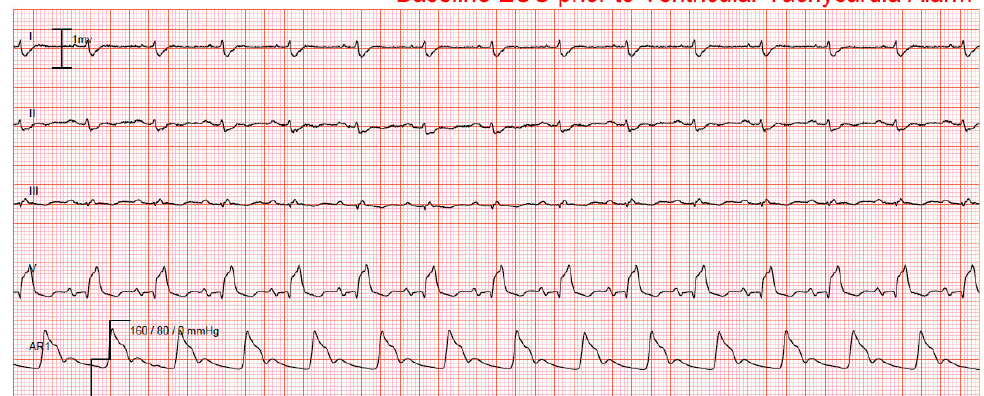
Figure 2. The figures above are rhythm strips showing leads I, II, III, and V (V1—at our hospital) and an arterial blood pressure waveform (AR1) in an intensive care unit patient. The top rhythm strip is an alarm for ventricular tachycardia (VT) during acute respiratory distress. Note the arterial blood pressure is unchanged at 146/89 mmHg and the Sp02 is 96% during the alarm. The bottom figure is a rhythm strip prior to the VT alarm showing normal sinus rhythm, first degree atrioventricular block with right bundle branch block (BBB). The arterial blood pressure is 138/59 and Sp02 is 99%. The QRS morphology in lead V1 in the top strip is identical to that of in the bottom tracings; hence, the top strip in not VT, but rather sinus tachycardia in a patient with right BBB during acute respiratory distress. This patient had a total of 79 false VT alarms (wide QRS heart rate > 100 beats/min) and 120 alarms for accelerated ventricular rhythm (wide QRS < 100 beats/min) during a seven-day ICU stay, illustrating the issue of false alarms due to BBB. Figure from the ECG Monitoring Research Lab, UCSF School of Nursing.